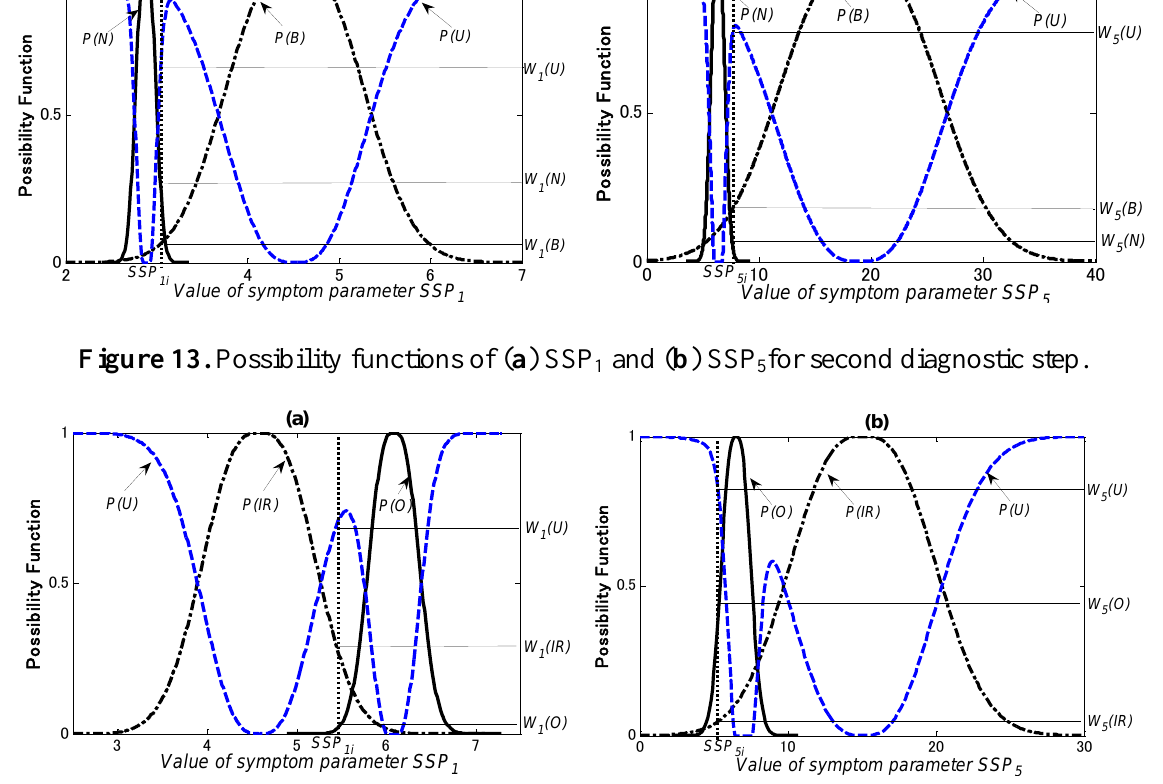
Figure 12. Possibility functions of ( a ) SSP